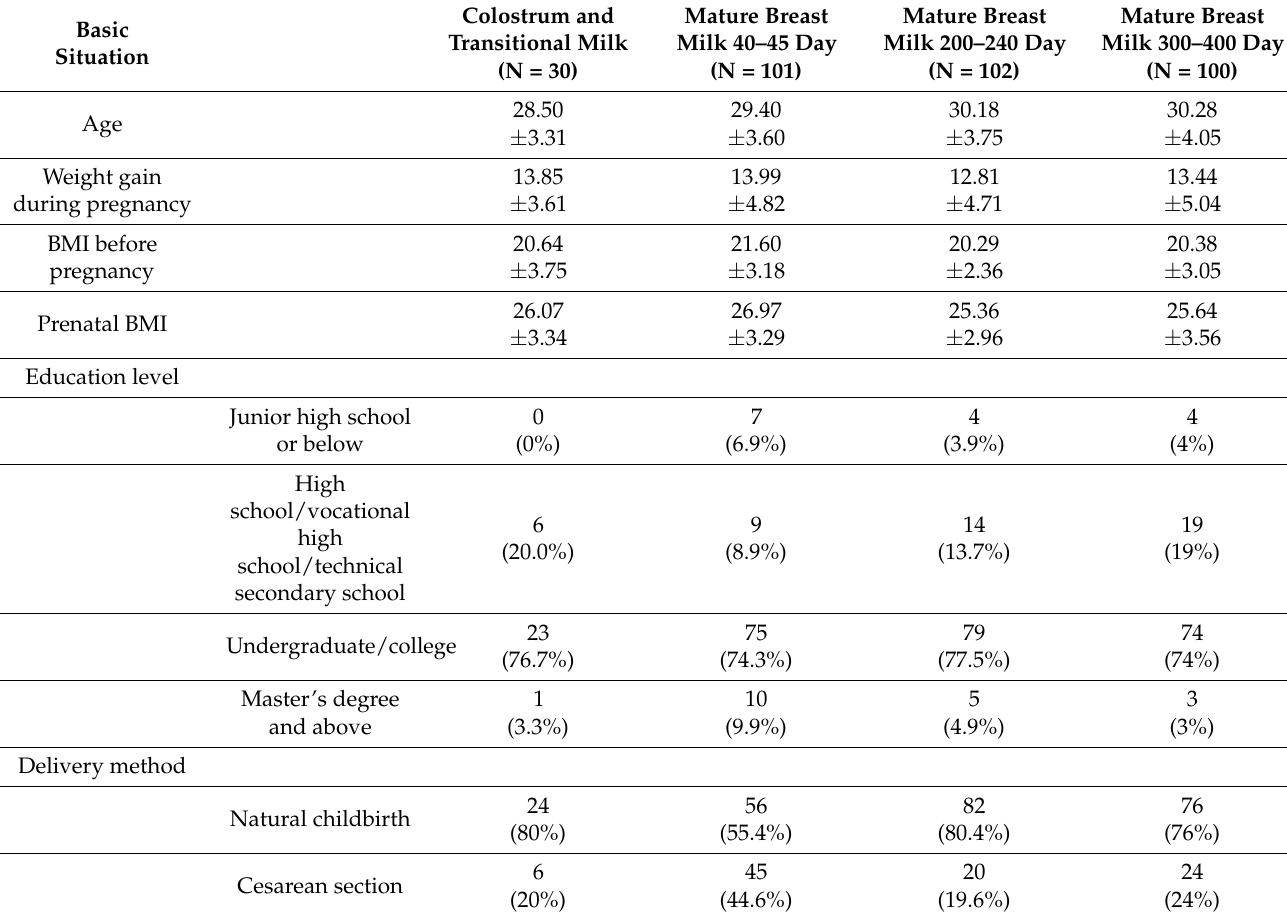
Table 1. Basic situation of lactating